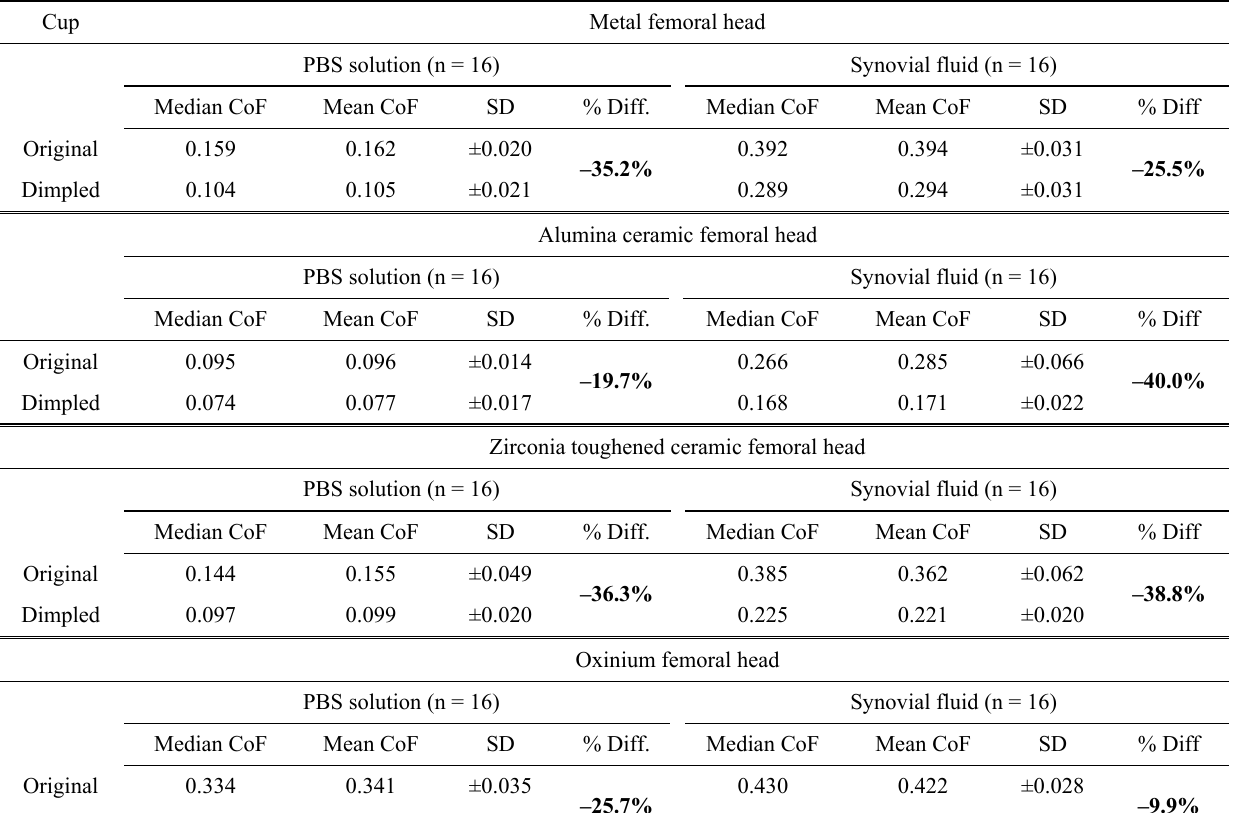
Fig. 8 Results summary (the number above each bar indicates mean coefficient of friction). Table 2 Results summary: n = number of measurements; CoF = coefficient of friction; SD = standard deviation; % Diff. = percentage difference, i.e., decrease of friction for the dimpled cup (for mean